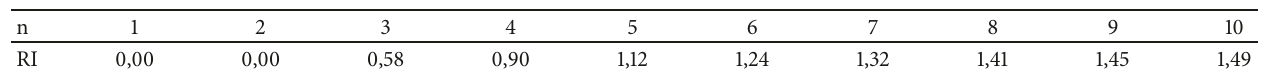
Table 3: Ratio index.